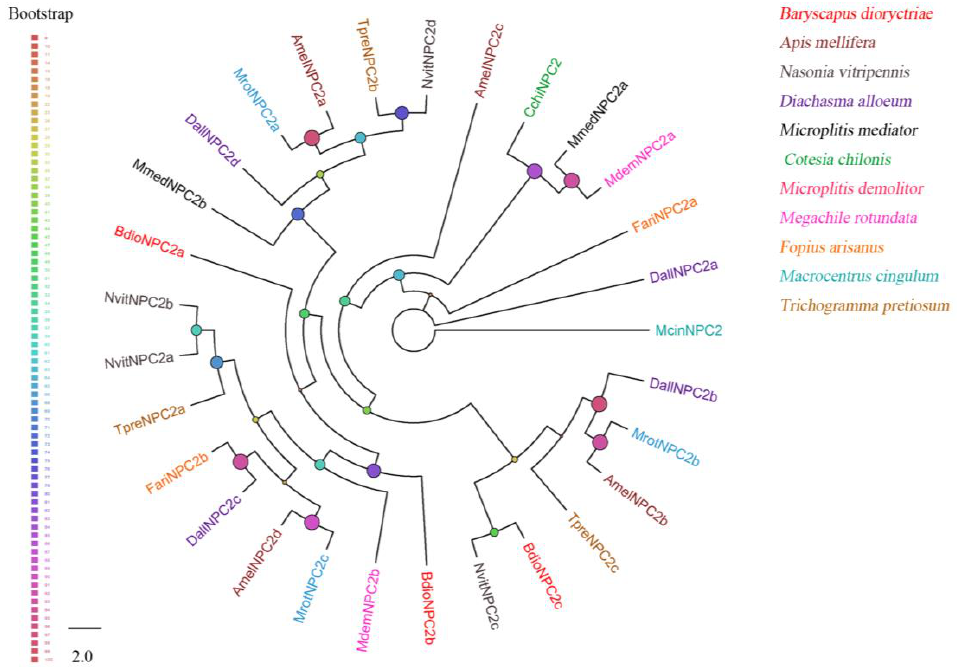
Figure 3. Phylogenetic tree of 29 Niemann–Pick type C2 proteins (NPC2s) from B. dioryctriae and other 10 Hymenoptera species. The protein sequences used in this phylogenetic analysis are listed in File S3. The size and color of the dots reflect their bootstrap values. The color scale is shown on the left, with larger dots indicating larger bootstrap values.